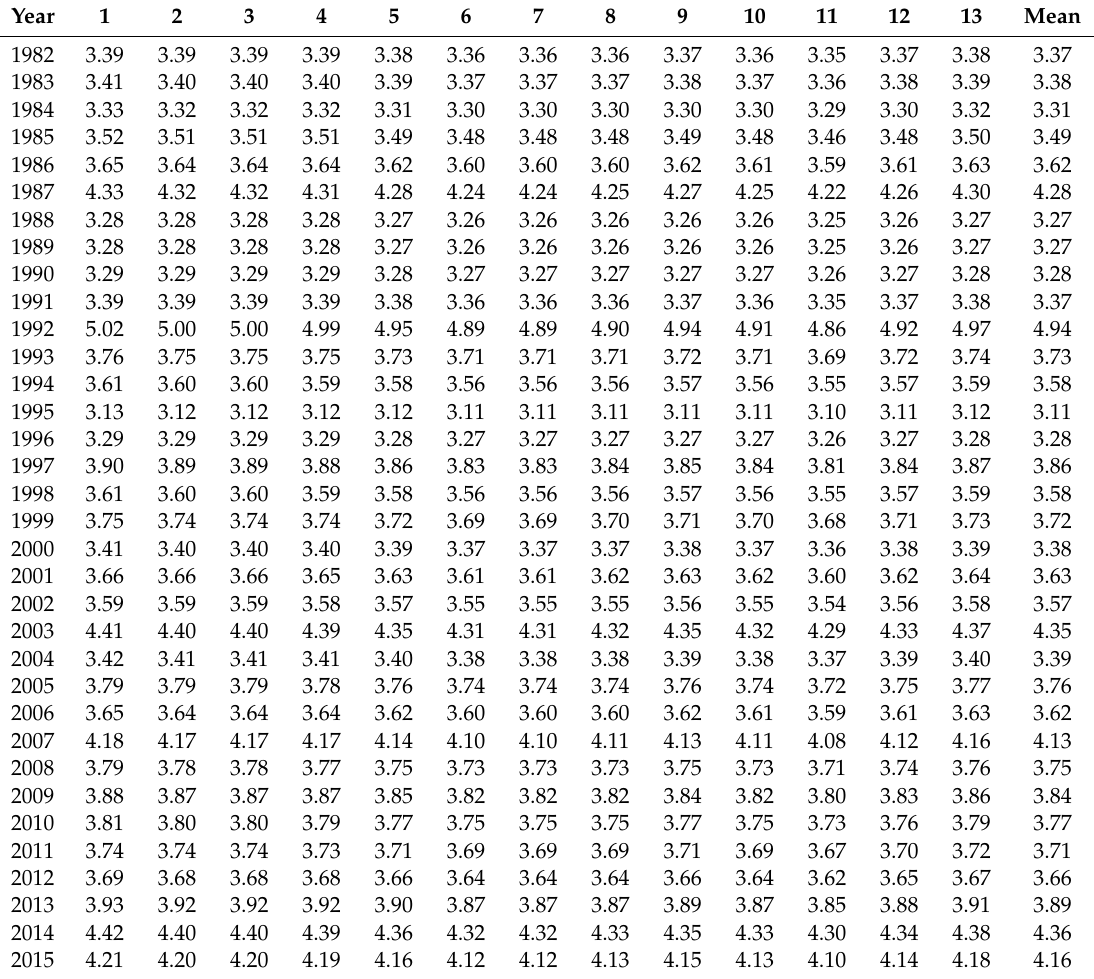
Table 3. Maximum water levels for the 13 measuring points during 1982–2015 (unit: m).